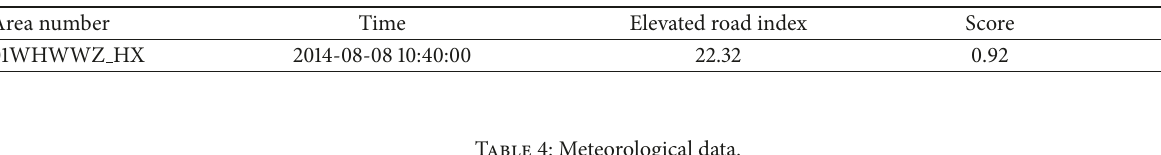
Table 3: Elevated road data.